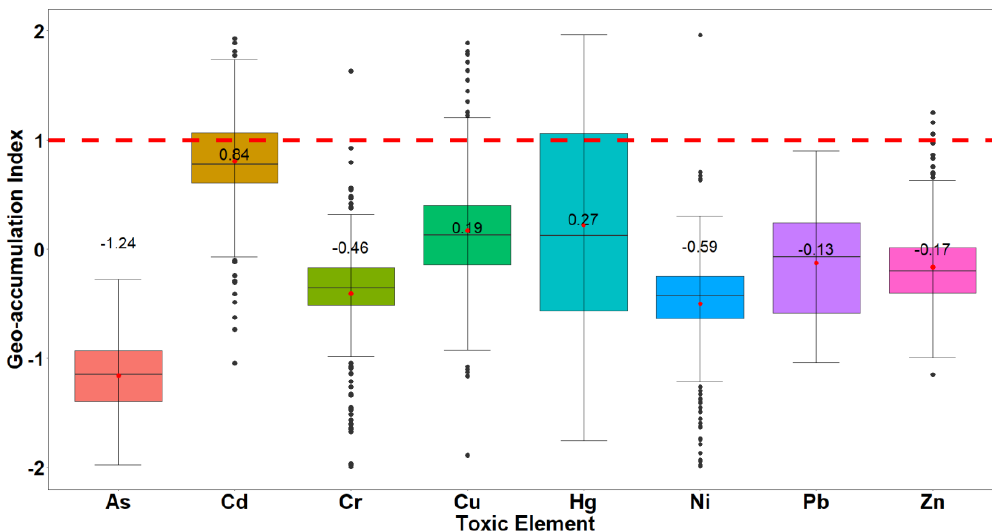
Figure 3. Boxplot of values of geo-accumulation index (the red dashed line means the threshold for occurrence of pollu- tion).